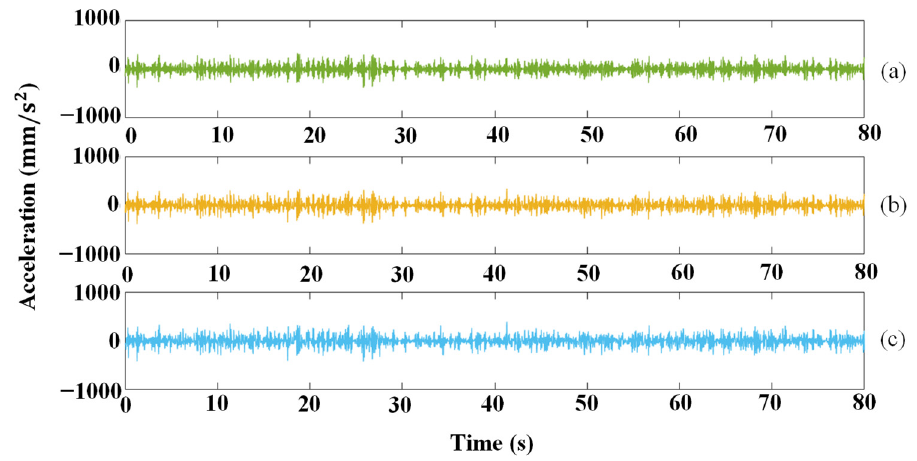
Figure 15. Corrected signals of static point of three methods: ( a ) EMD; ( b ) FT; ( c ) DF.